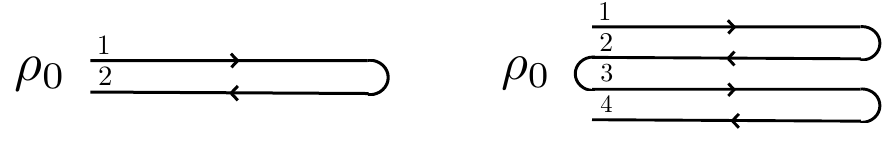
Figure 6 . Left: the hydrodynamic theory in a state (cid:26) 0 is formulated directly in real time on the CTP contour. Right: OTOCs (1.3) require a contour of four segments.